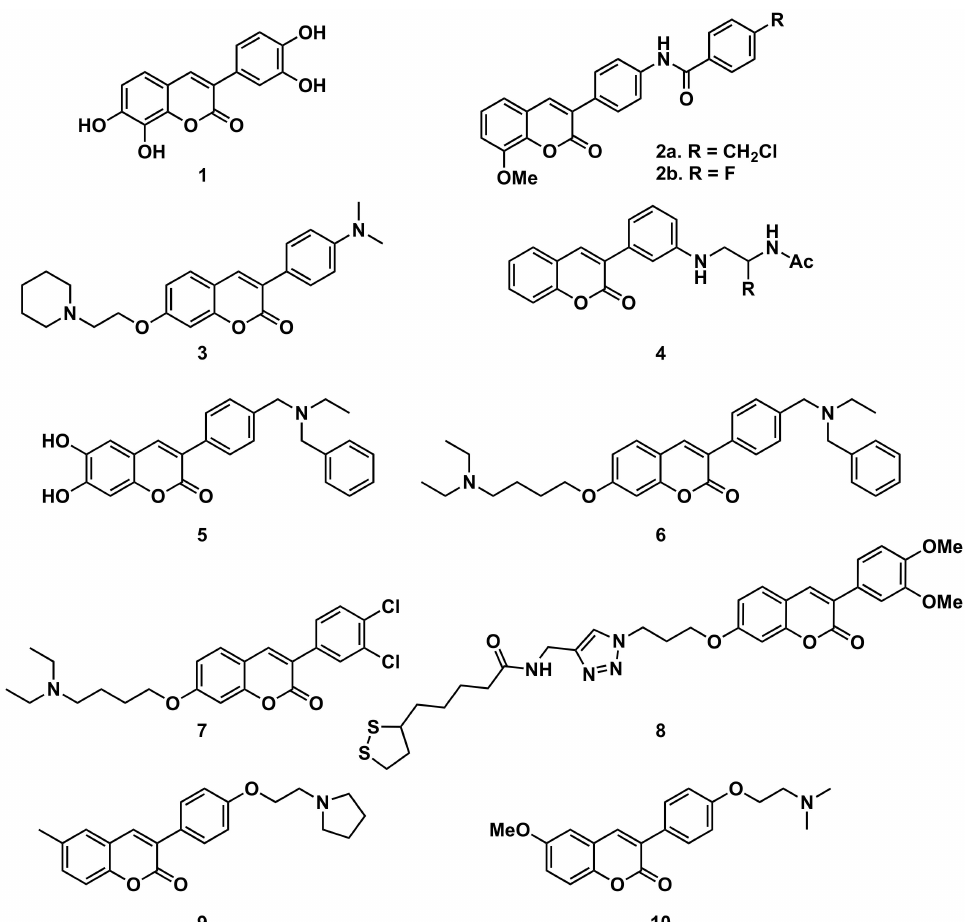
Figure 11. 3-Phenylcoumarins in Alzheimer’s disease: AChE